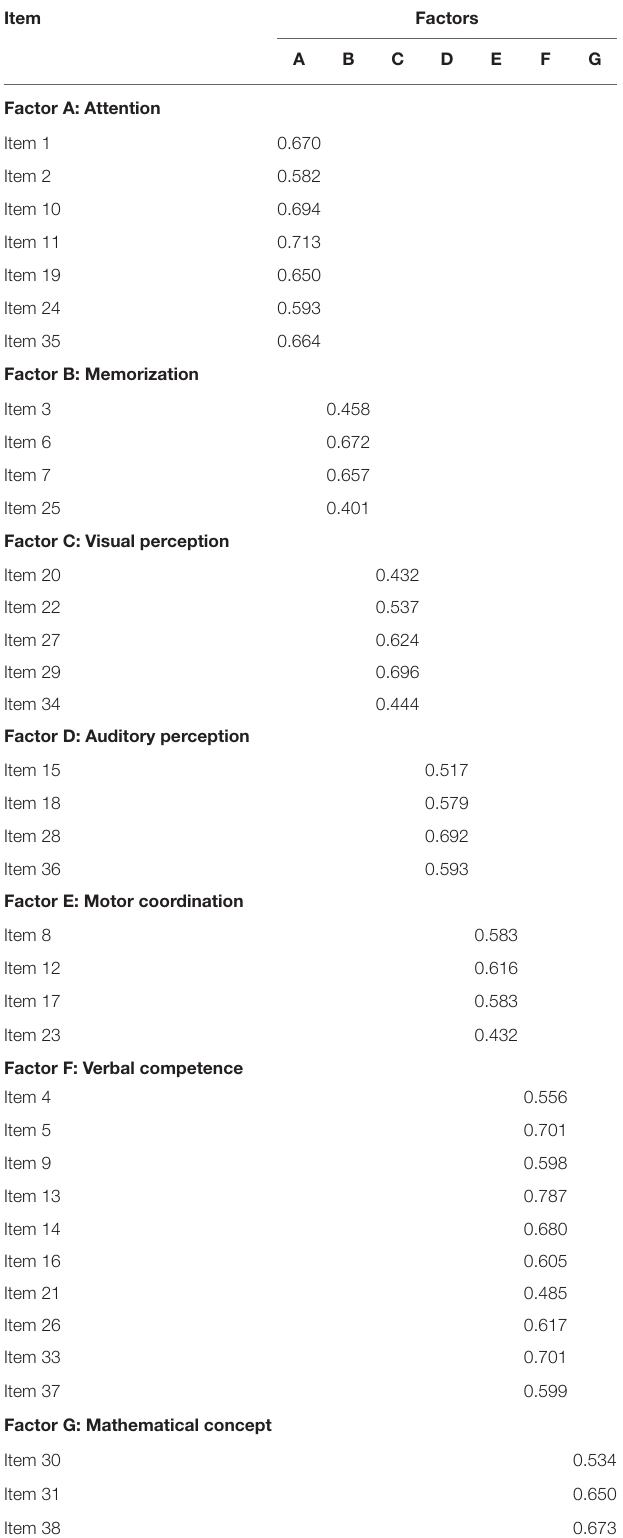
TABLE 2 | Factor loadings from the exploratory factor analysis of the preschool learning skills scale ( n = 1,540).